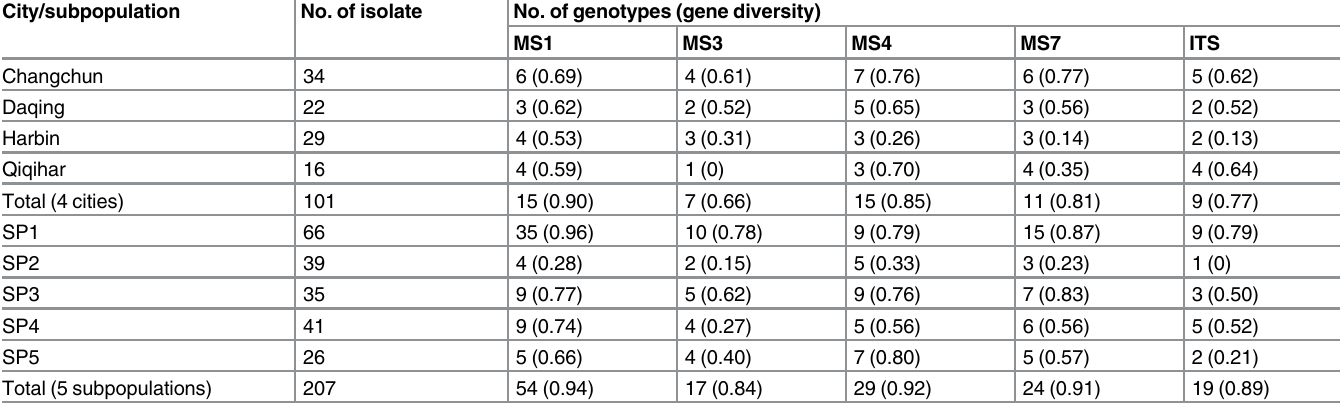
Table 2. Number of Enterocytozoon bieneusi genotypes based on combined sequence length and nucleotide polymorphism at four mini- and microsatellite loci. City/subpopulation